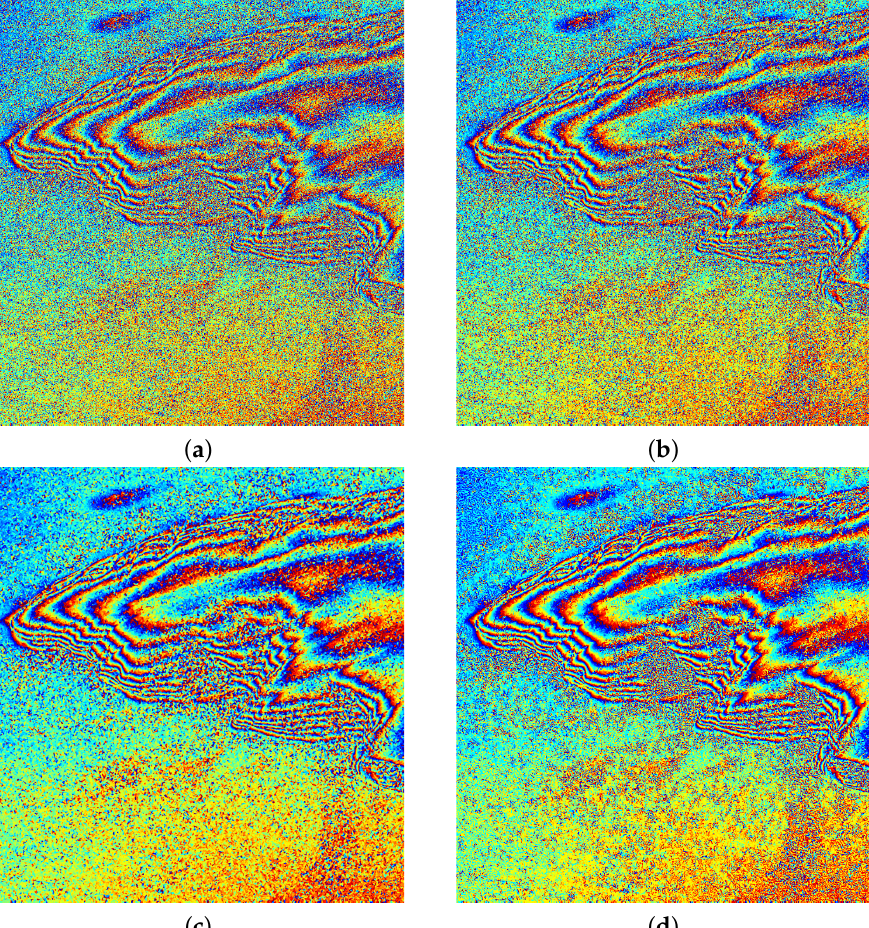
Figure 20. Filtered results of Figure 19 using four methods. ( a ) Lee filter. ( b ) Goldstein filter. ( c ) InSAR-BM3D filter. ( d ) Proposed